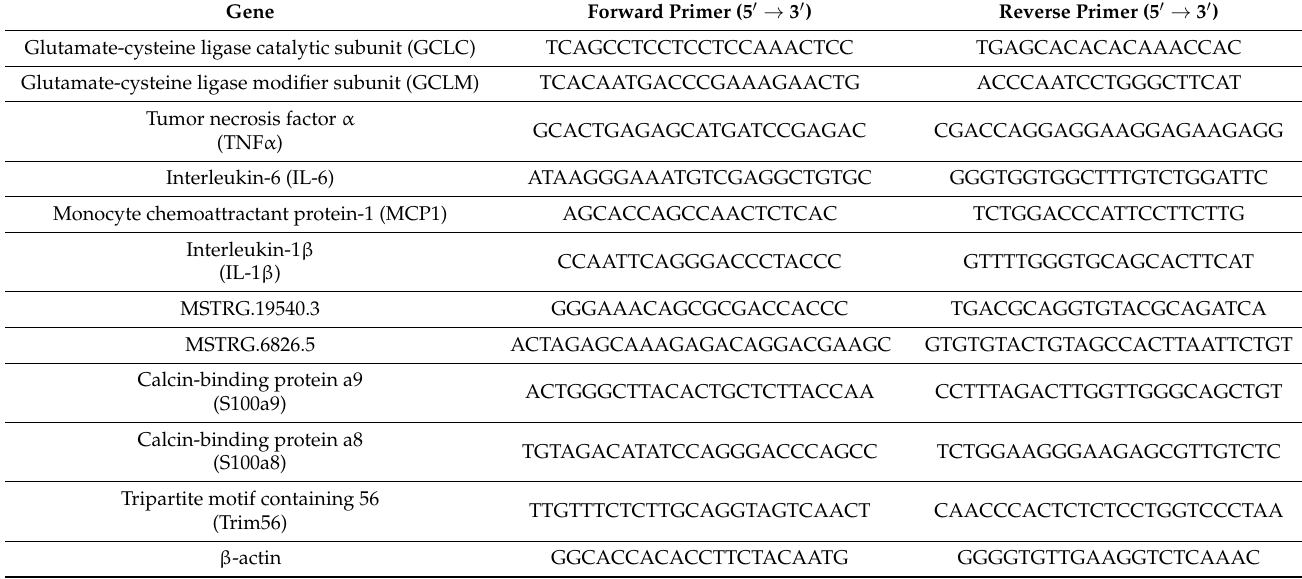
Table 1. Primers for RT-PCR